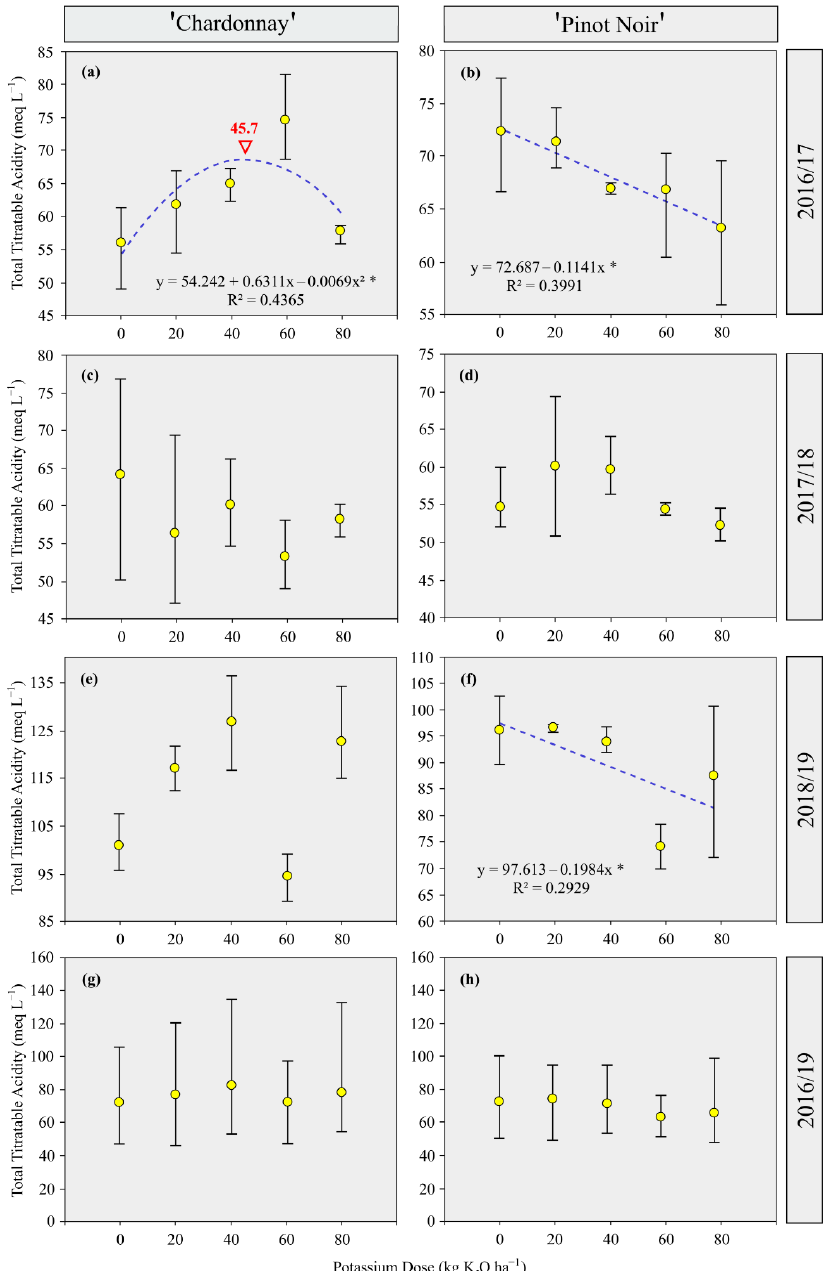
Figure 11. Potassium maximum technical efficiency (MTE) doses in relation to the total titratable acidity (TTA) of ‘Chardonnay’ ( a , c , e , g ) and ‘Pinot Noir’ ( b , d , f , h ), in 2016/17, 2017/18, 2018/19 and in a compilation of the crop seasons submitted to the application soil fertilized with K. The blue dotted line is the behavior of the equation. “*” Significant at 5% ( p < 0.05).